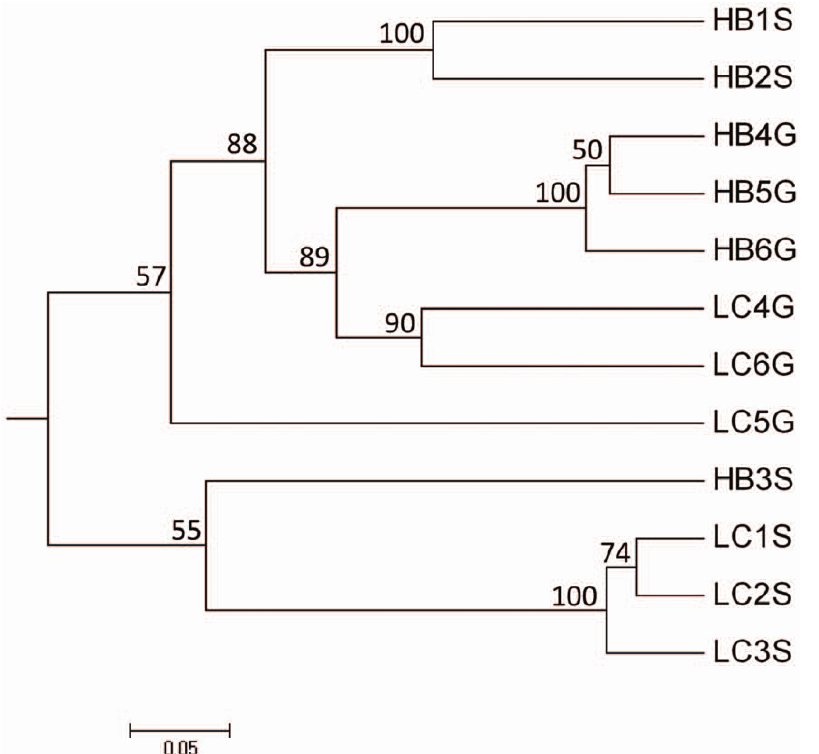
Figure 3. Cluster analysis based on UniFrac distances for sequences derived from the CloVR pipeline for each of the replicate Hackberry Bay (HB) and Lake Caillou (LC) stomach (S) and gut microbiomes (G).